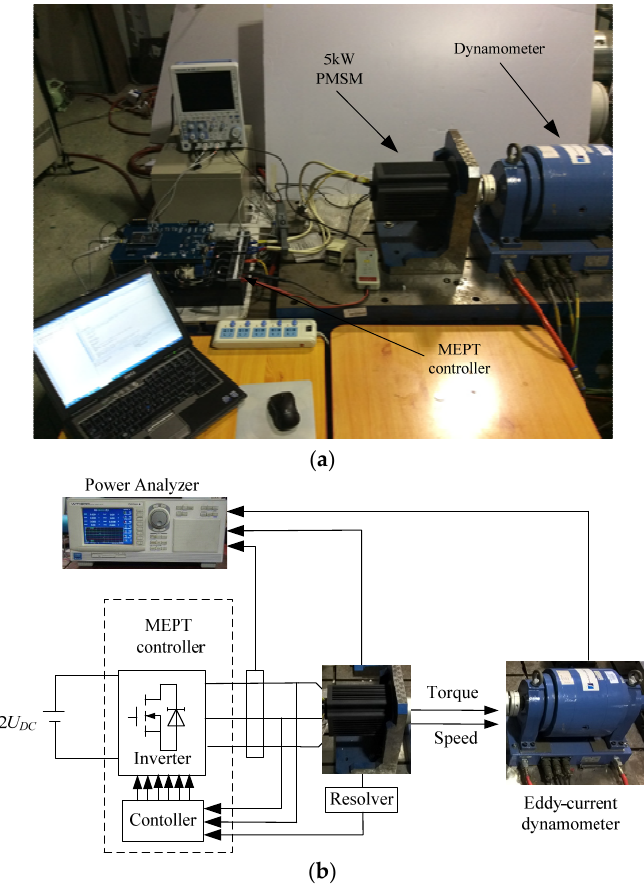
Figure 10. PMSM test platform: ( a ) Experimental platform; ( b ) Block diagram of test platform. The efficiency of the PMSM in SPWM is shown in Figure 11.